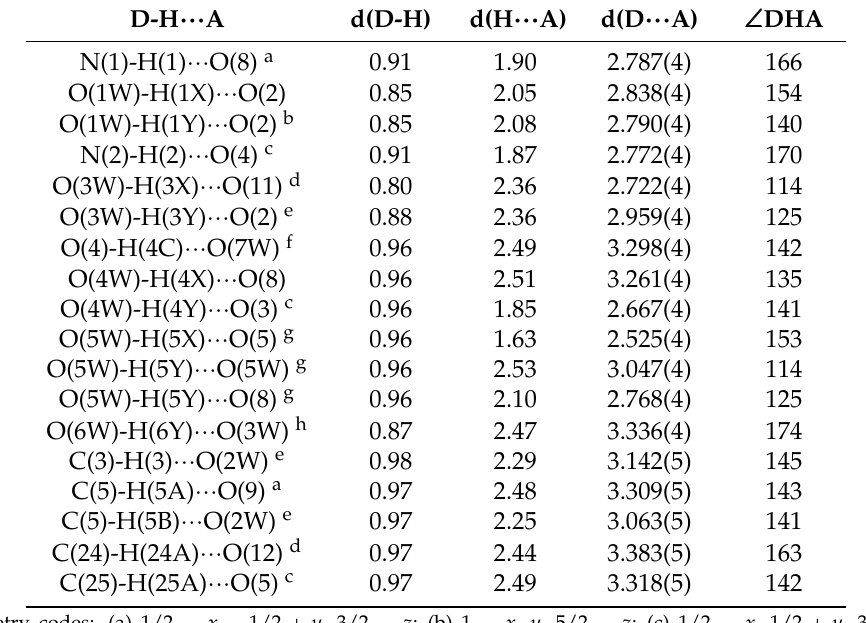
Table 2. Hydrogen bond lengths (å) and bond angles ( ° ) for [Cu 4 (HL) 4 (H 2 O) 14 ] n .